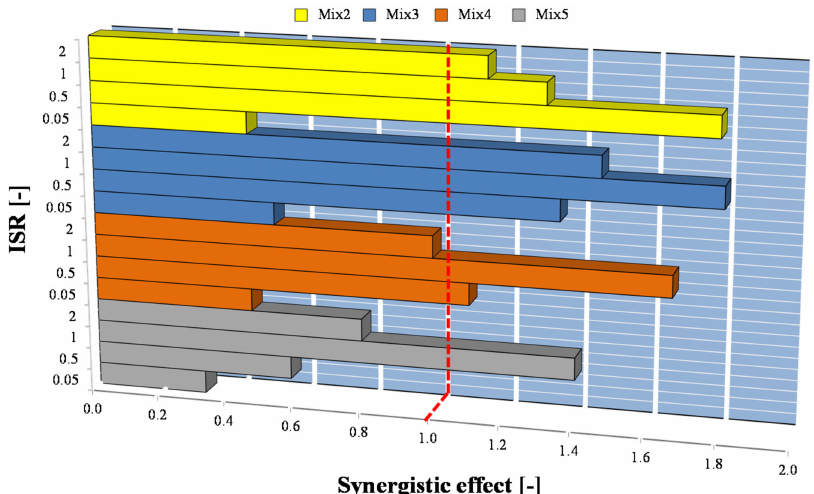
Figure 4. Results of the synergistic effect obtained in co-digestion of OFMSW and SS at different mixtures and